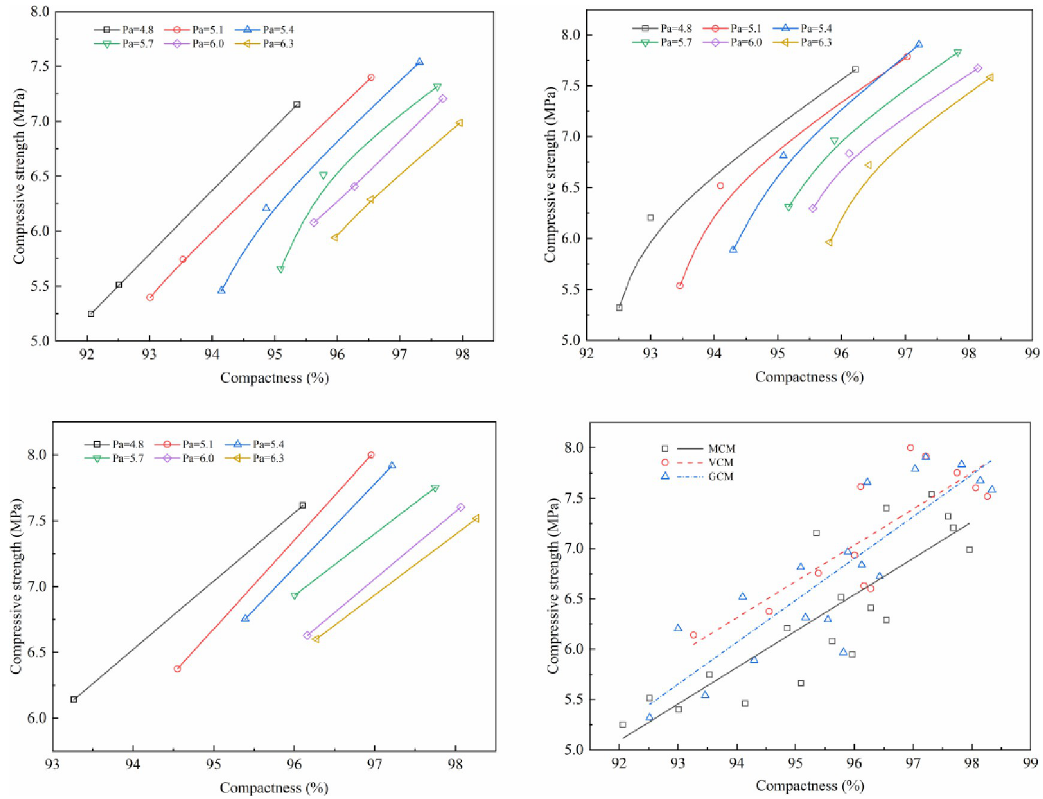
Fig 12. The relationship between compressive strength and compactness. (a) Compressive strength versus compactness under MCM (b) Compressive strength versus compactness under GCM. (c)Compressive strength versus compactness under VCM (d) Relationship between compressive strength and